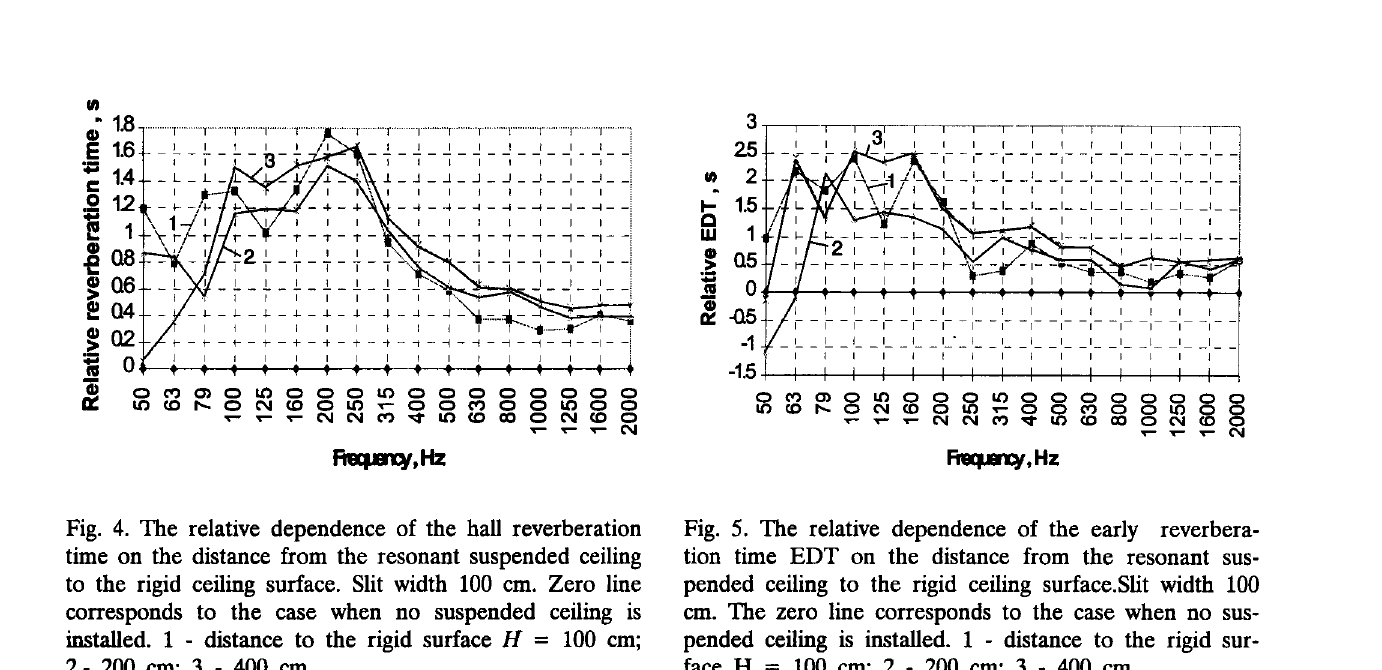
Fig. 5. The relative dependence of the early reverbera tion time EDT on the distance from the resonant sus pended ceiling to the rigid ceiling surface.Slit width 100 em. The zero line corresponds to the case when no sus pended ceiling is installed. 1 - distance to the rigid sur face H = 100 em; 2 - 200 em; 3 - 400 em.